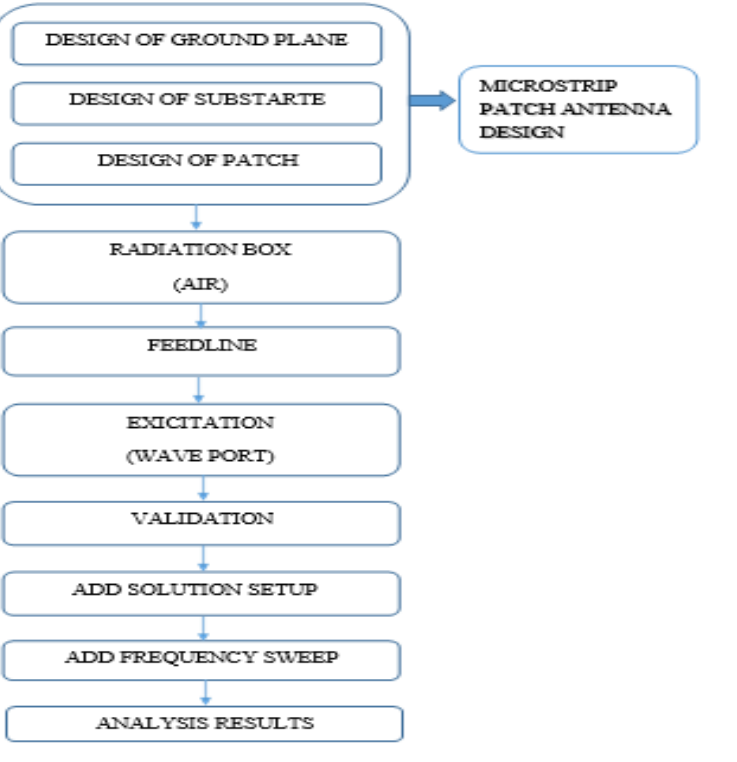
Figure 4. Flowchart of antenna design.